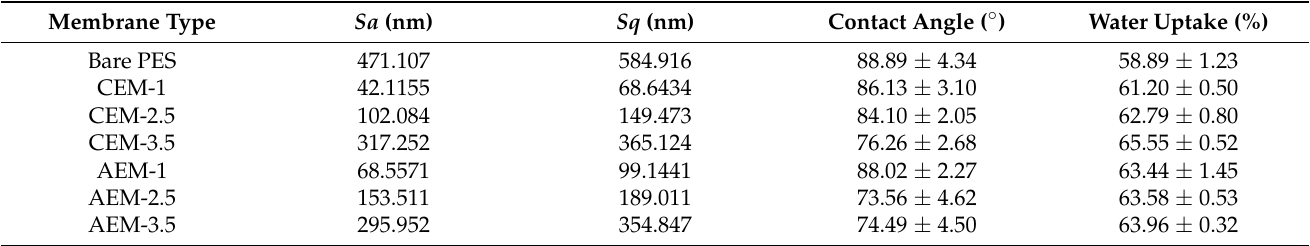
Table 2. The mean surface roughness (Sa), root mean square roughness (Sq), contact angle and water uptake of the prepared bare PES membrane, CEMs and